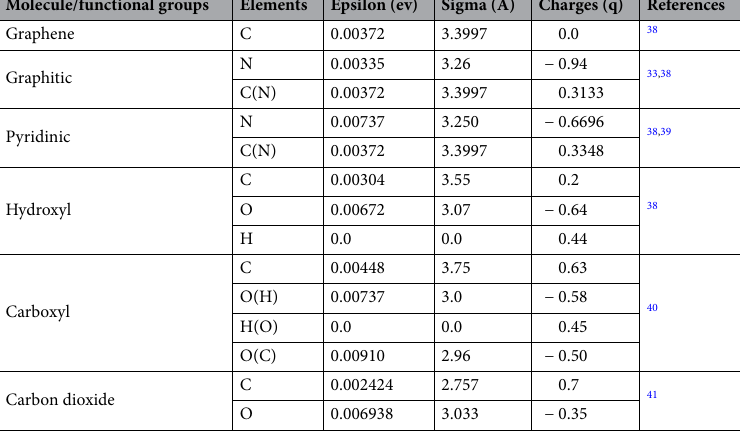
Table 2. Lennard Jones parameters and partial